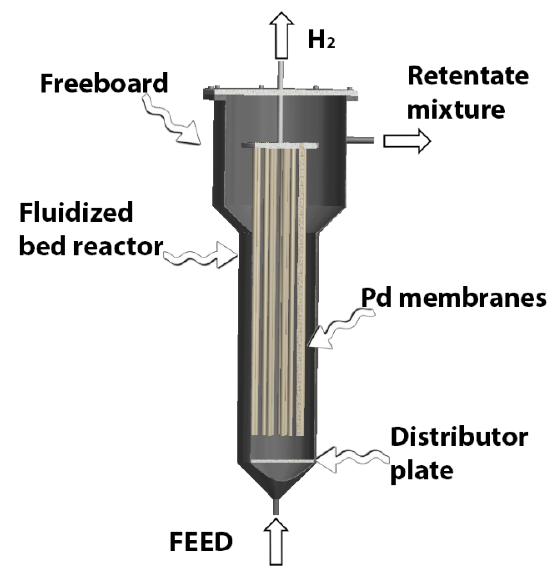
Figure 1. Schematic of an inorganic membrane reactor. Hydrogen is produced on catalyst particles and removed via Pd-based membranes.